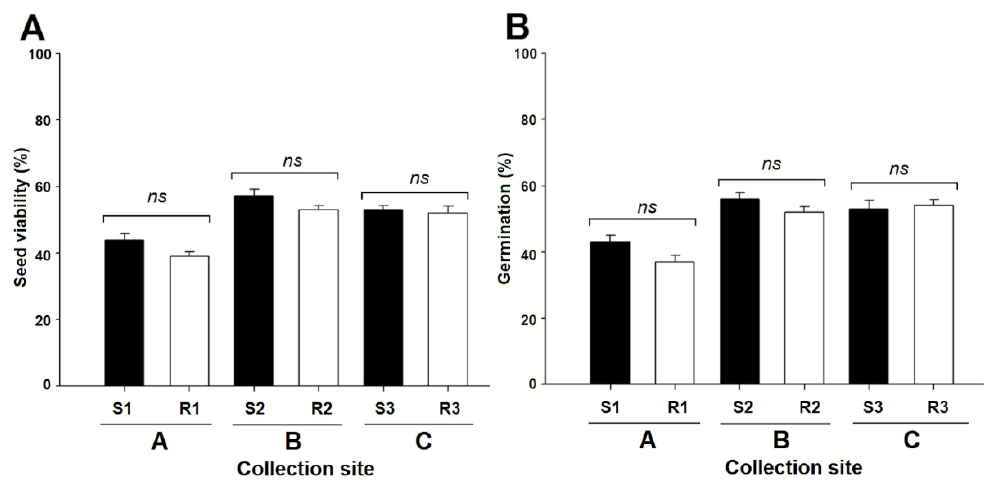
Figure 3. Embryo viability and germination potential in seeds of glyphosate-susceptible (S) and -resistant (R) Conyza bonariensis biotypes. Seeds were collected in Passo Fundo-RS ( A ), Palmeira-PR ( B ), and Matão-SP ( C ), Brazil. Vertical lines represent the standard error of means ( n = 4) using 50 seeds per replicate. ns : no statistical differences within a collection site according to the 95% Tukey test.